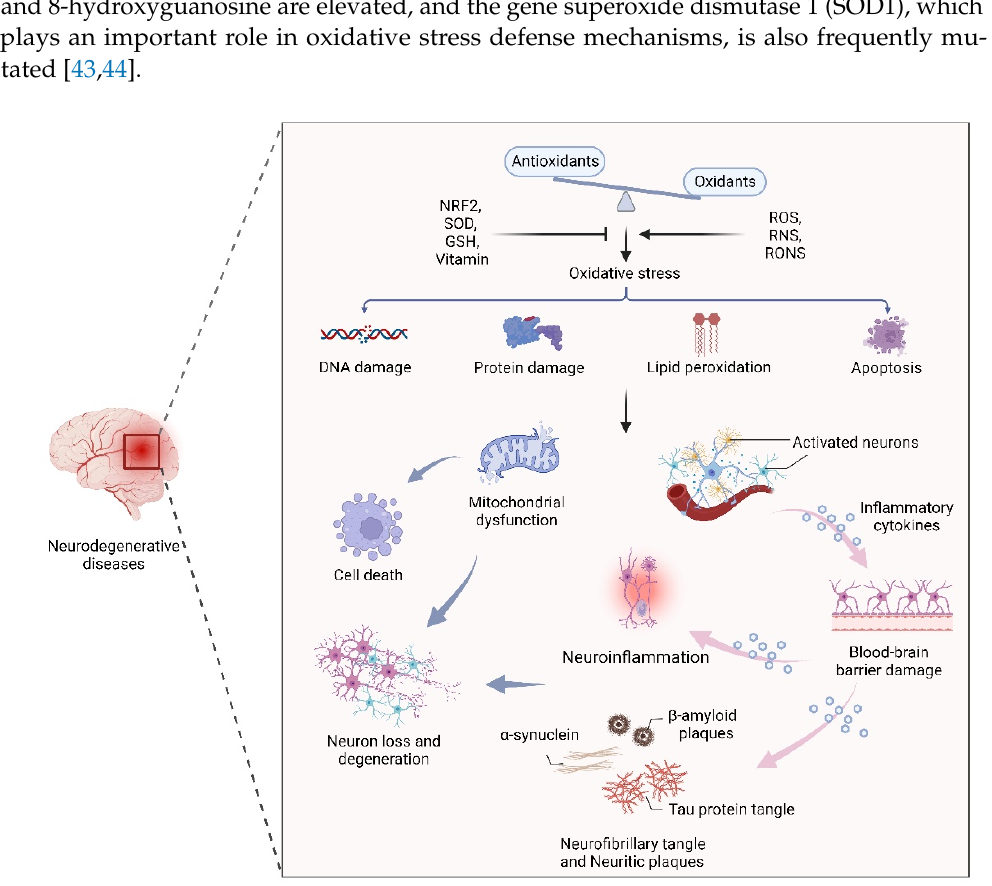
Figure 1. The effect of oxidative stress in neurodegenerative diseases. An oxidant/antioxidant imbalance leads to oxidative stress, which causes DNA and protein damage, lipid peroxidation, and apoptosis. Dysfunctional mitochondria and activated neurons secrete inflammatory cytokines that cross the blood–brain barrier, leading to inflammation, α -synuclein, β -aggregation, and neuronal plaque accumulation in neurons, leading to neuron loss and